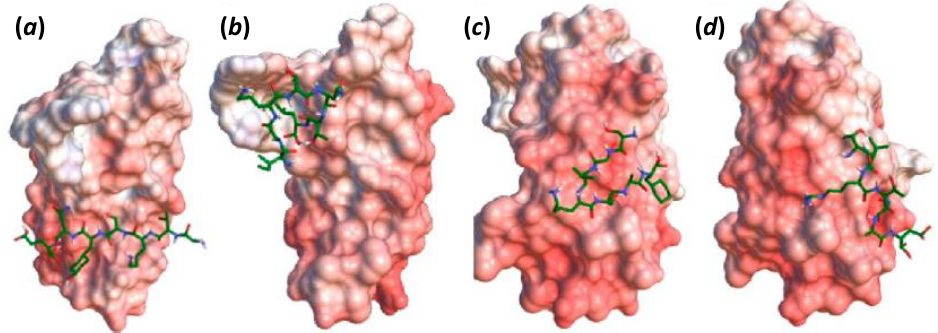
Figure 6. Electrostatic surface of extradomain-B fibronectin fragment (EDB) and 3D stick molecular models (C = green, N = blue, O = red and H = white) of peptides ( a ) GVK, ( b ) IGK, ( c ) SGV and ( d ) ZD2 fitted to the protein. For the surface of EDB, blue indicates positive charged residues, red represents negative areas and white are neutral regions. Reprinted with permission from Ref. [41] (Copyright, 2017, American Chemical